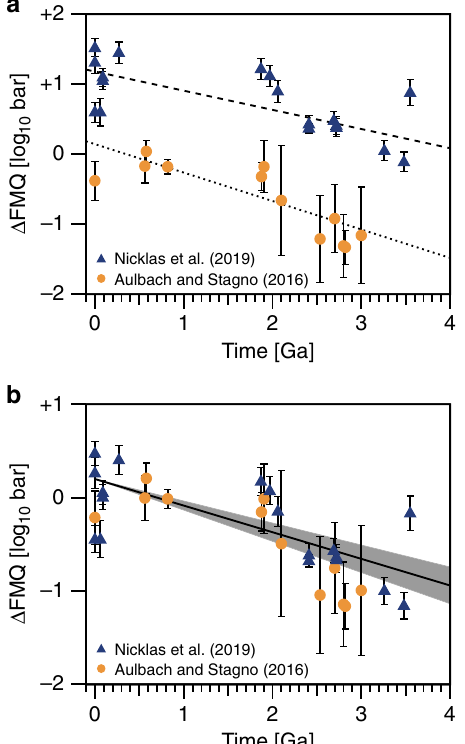
) Fig. 1 Evolution of the oxygen fugacity of mantle. The oxygen fugacity ( f O 2 is in log units relative to the Fayalite – Magnetite – Quartz (FMQ) buffer. In 10 a , we show original data of Aulbach and Stagno 45 and Nicklas et al. 46 . Dotted and dashed lines in a represent a linear fi t for the data of Aulbach and Stagno 45 and Nicklas et al. 46 , respectively, showing similar trends. Both datasets should converge on an average modern f value inferred from O 2 mid-ocean ridge basalt (MORB). So, in b , we anchor the datasets to the MORB-inferred f of the modern mantle, 0.2 50 . Thus, 0.2 is added to O 2 Aulbach and Stagno data 45 and − 1.00 to Nicklas et al. data 46 . The black solid line and gray shaded region in b represent the median value and 95% con fi dence interval of oxygen fugacity, respectively. The error bar represents uncertainty of 1 σ . The gray shaded region corresponds to a variation of the slope of the linear fi t, which is propagated from the variations of the samples (i.e., the error bars). Note that in b , the variation of the f of the modern mantle, which is discussed later, is O 2